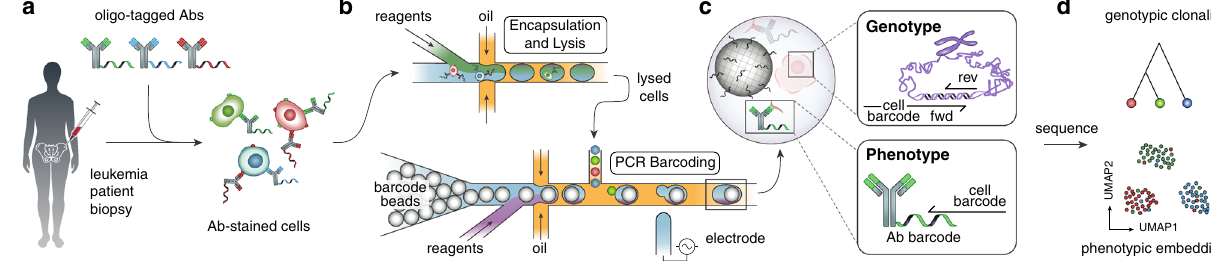
Fig. 1 The DAb-seq work fl ow. a Bone marrow aspirates of patients with AML contain healthy and malignant cells that exhibit diverse genotypes and immunophenotypes. These cells are stained with antibodies labeled with DNA tags. b Stained cells are paired and encapsulated with a barcode bead on a Mission Bio Tapestri instrument. c In each droplet, a PCR labels antibody tags and genomic DNA targets simultaneously with a unique cell index. d Sequencing the barcoded amplicons and antibody tags yields coupled single-cell immunophenotype and genotype data for thousands of